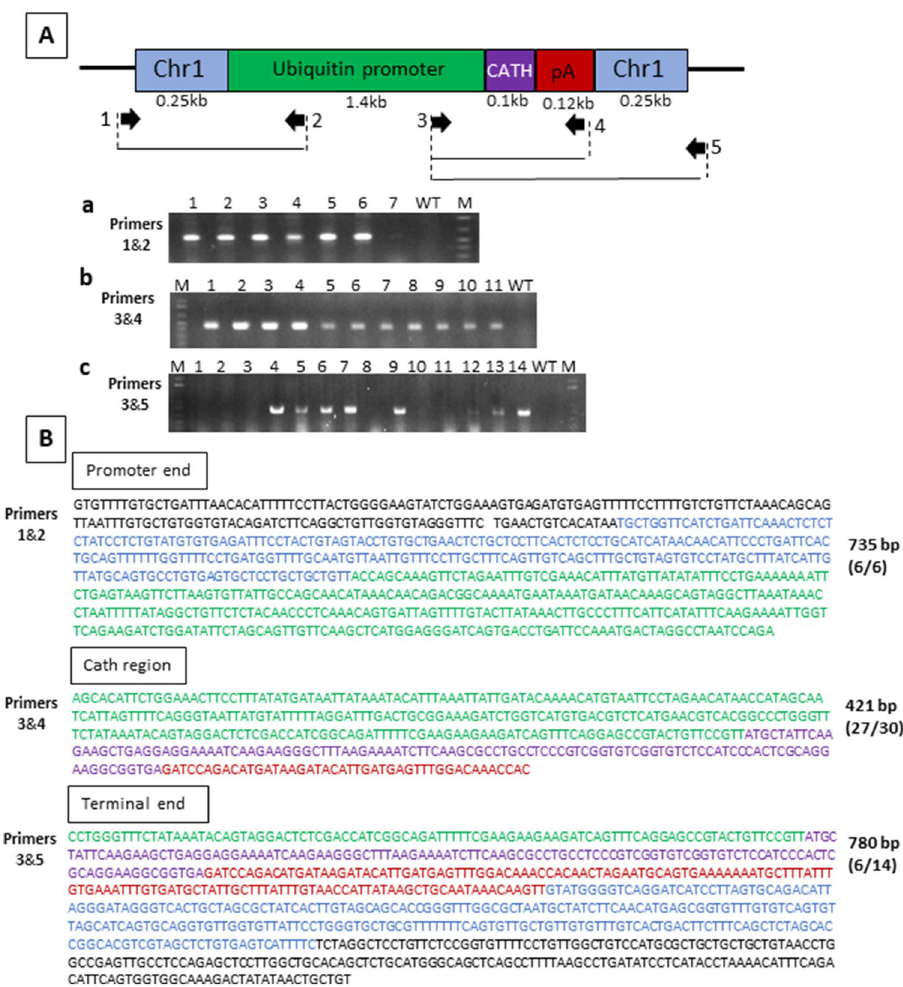
Figure 3. Genotyping strategy for CRISPR/Cas9 knock-in of channel catfish ( Ictalurus punctatus ) using dsDNA construct driven by zebrafish ubiquitin promoter carrying the alligator cathelicidin gene (dsDNA-UBI-Cath). ( A ) Schematic diagram of dsDNA-UBI-Cath construct. (a, c) PCR amplification of primer sets at the 5 ′ and 3 ′ junctional regions (primer sets 1&2 and 3&5) and (b) the insert-specific region for alligator cathelicidin gene (primer set 3&4). Numbers in a lane represent individual samples of fish, lane WT represent wild type channel catfish and lane M indicates DNA marker. Presence of a distinct band indicates positive for transgene. Gel electrophoresis images shown here are cropped; full-length gels are presented in Supplementary Figure S1. ( B ) Representative sequences derived from channel catfish positive for integration of the dsDNA-UBI-Cath construct. Sequences in black are the regions outside of homologous arms; Blue sequences are the homologous arms that are part of the transgene construct; Green are partial sequences from the ubiquitin promoter region; Purple are the sequences of alligator cathelicidin gene. Red sequences belong to the poly A terminator sequence. Numbers on the right side of each sequence indicate the number of base pairs in the promoter region, alligator cathelicidin gene region and terminal region as revealed by sequencing of positive fish. Numbers in parentheses are the number of sequencing reactions which yielded positive transgene integration over the total number of sequencing